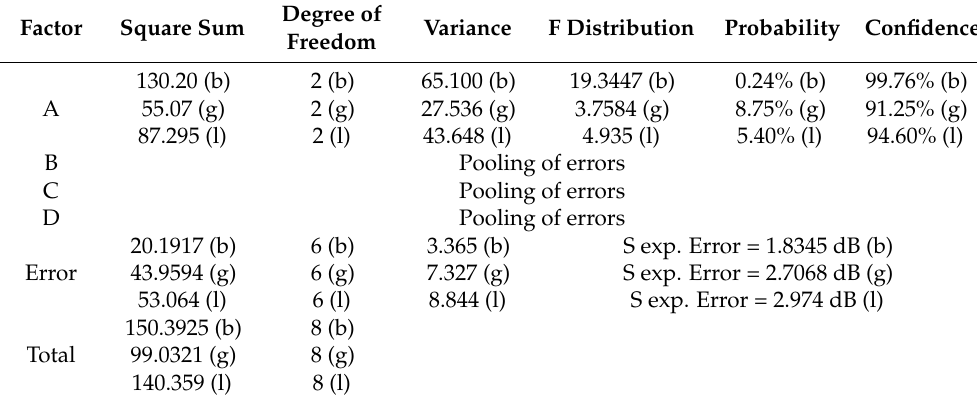
Table 7. Pooling of errors of S/N ratio of base, gear, and linkage parts for the